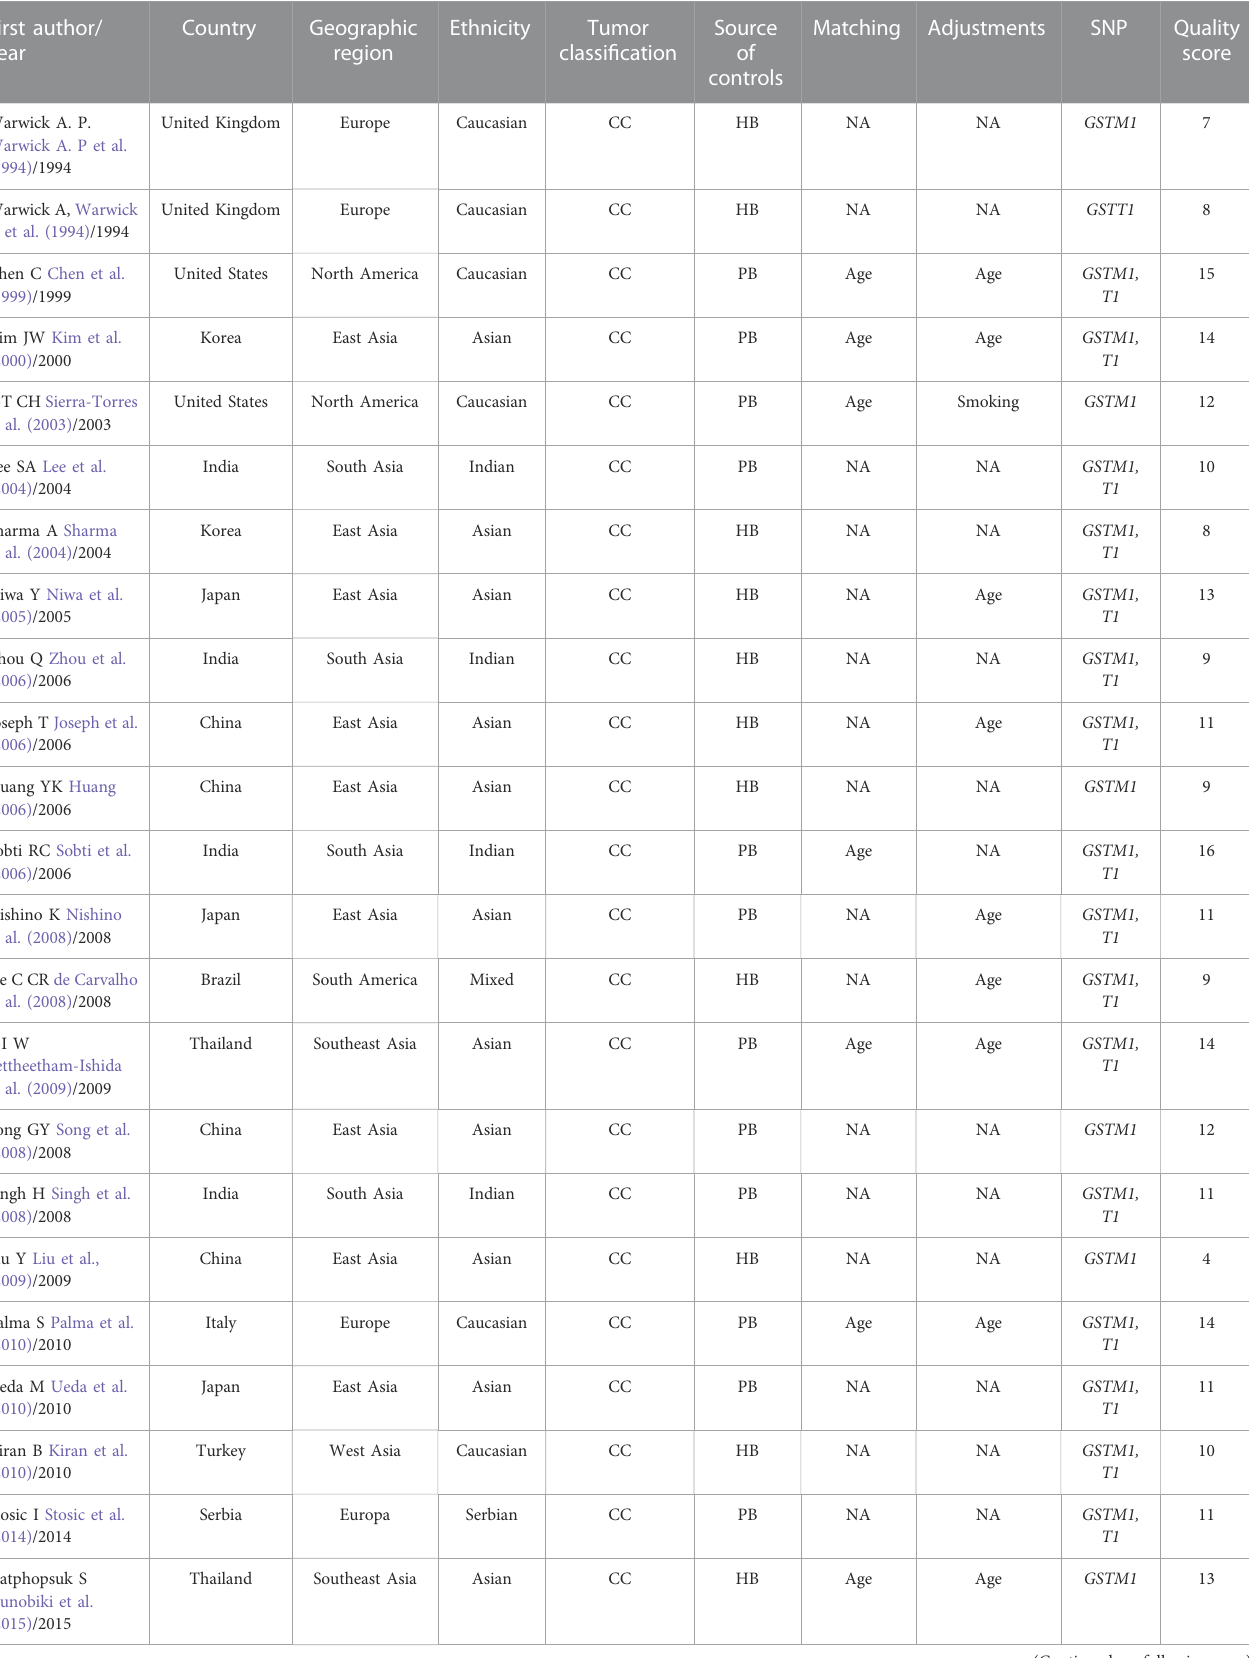
TABLE 1 General situation and quality evaluation of the included